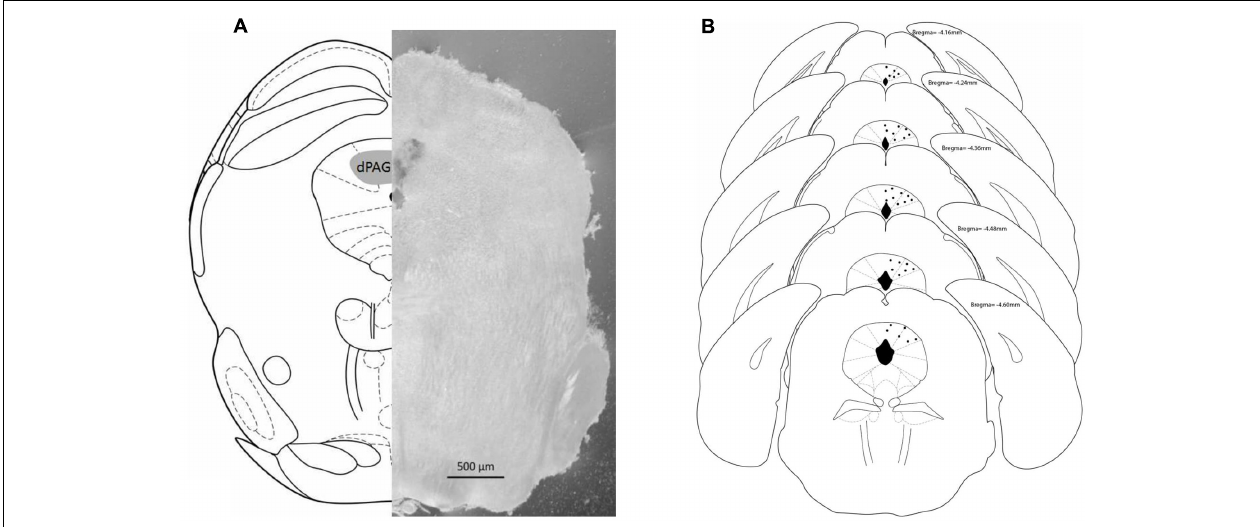
FIGURE 2 | (A) Schematic representation (left) and photomicrograph (right) of the mouse brain. Both frames (left and right) correspond to –4.16 mm from bregma. (B) Schematic representation of microinjections sites within dPAG. Number of dots are representative and fewer than the actual number of animals due to overlapping. Histology revealed that all positive injection sites were between –4.16 and –4.60 mm from bregma (based on Paxinos and Franklin,